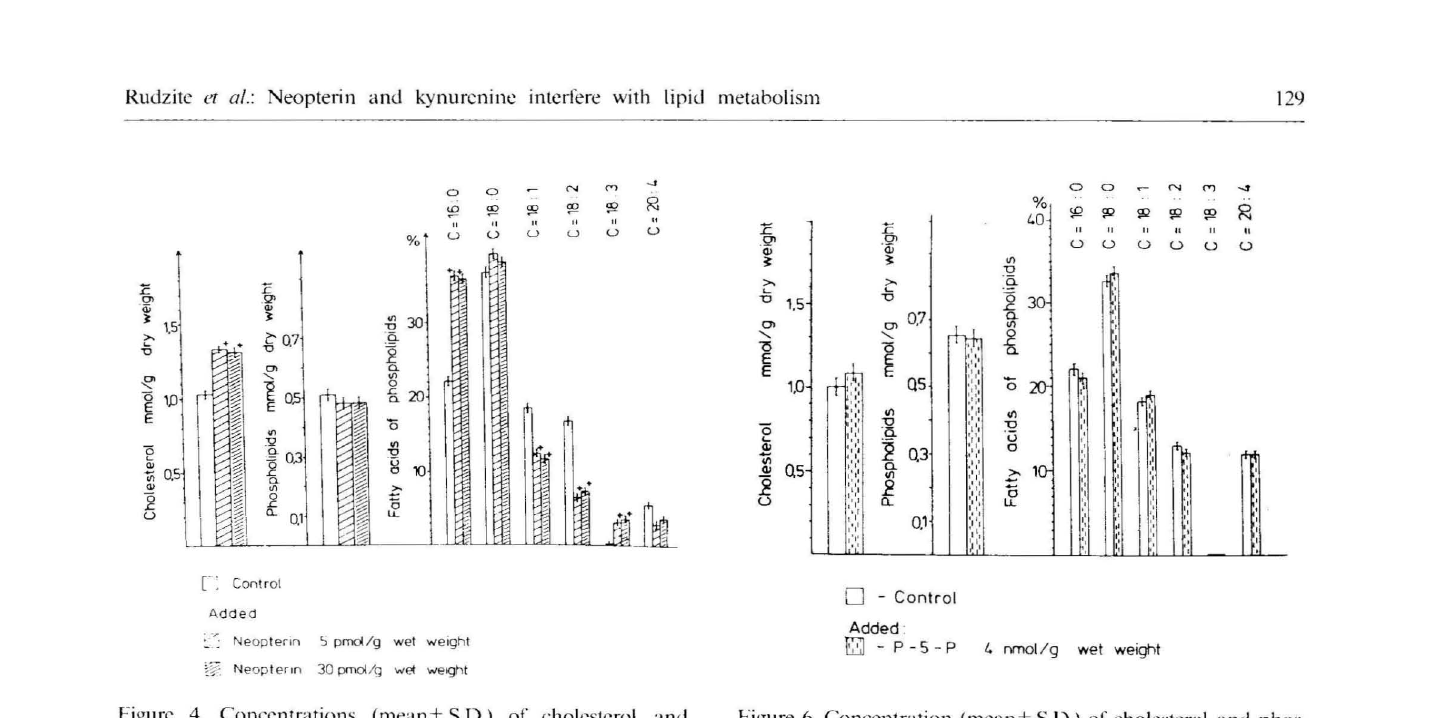
Figure 6. Concentration (mean± S.D.) of cholesterol and phos pholipids as well as f~ltty acid content (in percent: mcan± S. D.) in controls (L.I) and in samples with 4 nmol P-5-P/g wet weight (J). of rat tissue homogenate used for phospholipid biosynthesis in vitro. Ineuhation medium: Krehs-Ringer-phos phate huller (pH 7.4). fatty acid mixture and glycerol. Samples were incubated twice for 4 h al 37°c.